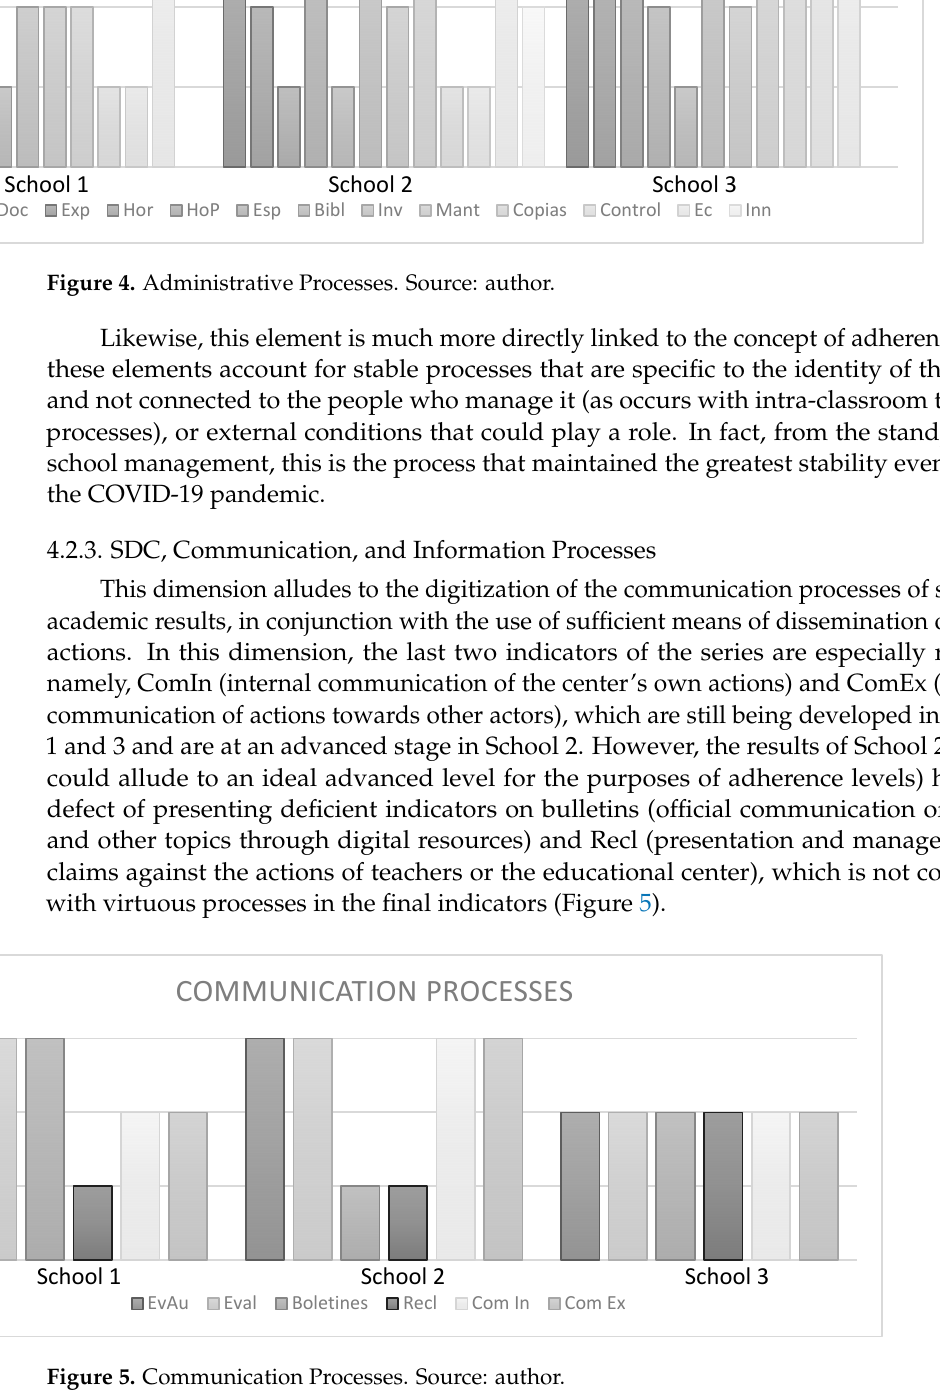
Figure 5. Communication Processes. Source: author.